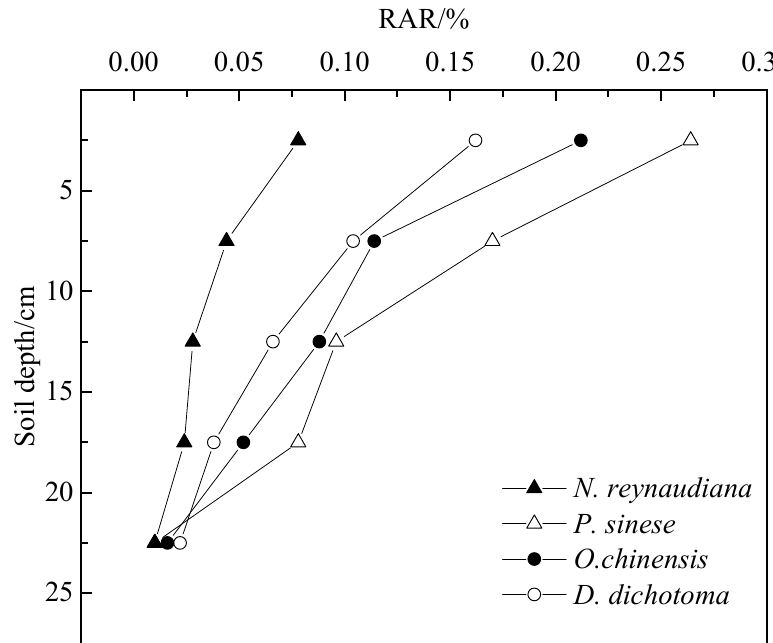
Figure 10. Changes of root RAR of the four herbaceous plants with soil depth. The shear strength enhancement value obtained via actual measurements, the shear strength enhancement value determined via calculations and simulations, and the correc- Table 11. Simulation and modification results of WWM model under different vegetation types. tion coefficient ( k (cid:48) ) are provided in Table 11. The table indicates that except for the four soil layers of 5–10 cm, 10–15 cm, 15–20 cm, and 20–25 cm, the predicted values obtained with the WWM model underestimated the measured increase in shear strength. The correction coefficient k (cid:48) for each soil layer under the different vegetation conditions varied between 0.20 and 20.25. The average correction coefficient k (cid:48) for Neyraudia reynaudiana was 0.88, that for Pennisetum sinese was 4.15, that for Odontosoria chinensis was 9.74, and that for Dicranopteris dichotoma was 5.00. The average correction coefficient k (cid:48) of the WWM model with four species of vegetation was